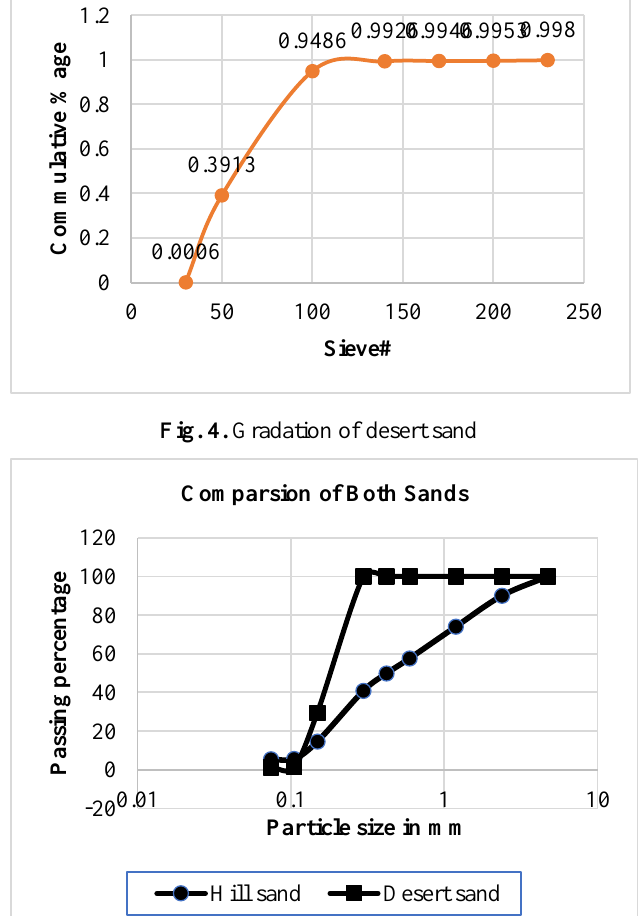
Fig. 3. Gradation of hill sand Curve Of Desert